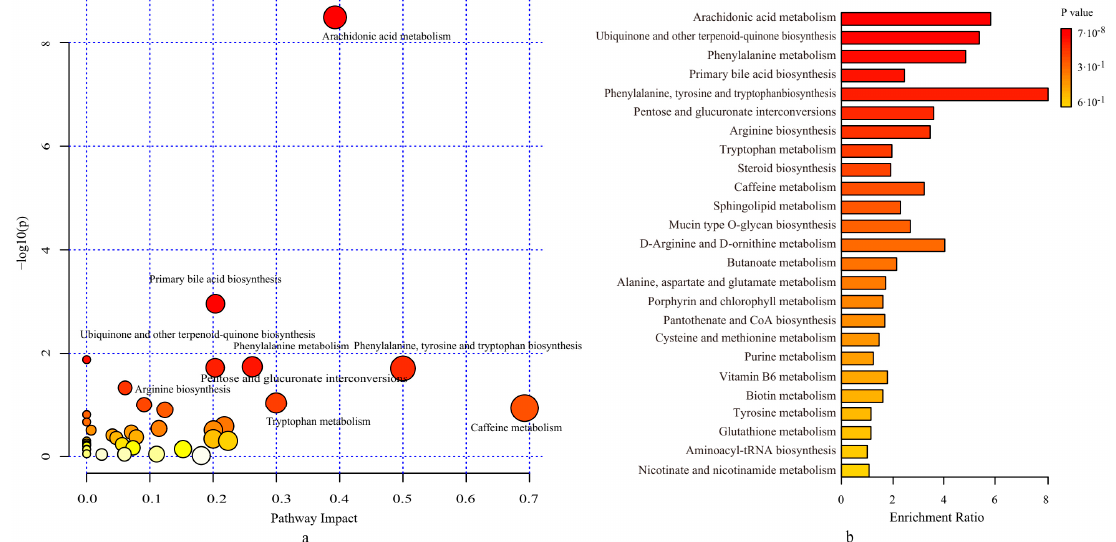
Figure 6. Metabolic pathway analysis of differential fecal metabolites identified from the probiotics group compared with the controls. ( a ) Functional enrichment analysis of pathways using metabolite set enrichment analysis (MSEA). The enrichment ratio is the ratio between observed hits and expected hits; ( b ) Significantly changed pathways based on enrichment analysis ( p -values) and topology analysis (pathway impact).